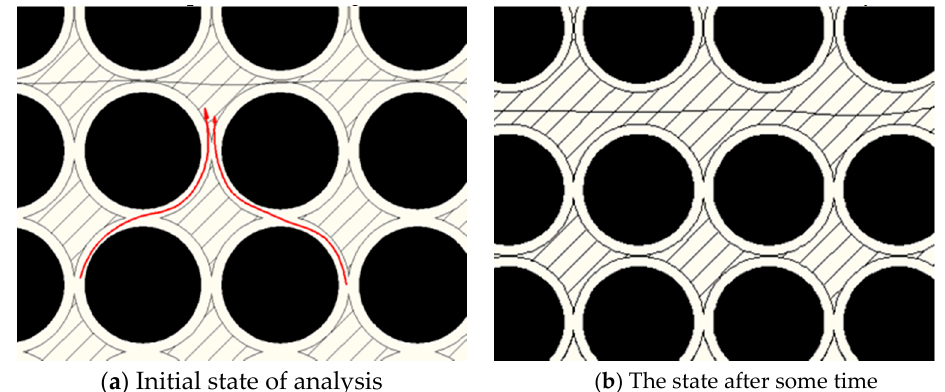
Figure 4. Schematic of freezing soil whose void ratio is less than e sep or equals to e sep : soil grains, the circles filled with black shadow; ice crystals, the circles or ellipses with slashed shadow; the ice block, the slashed shadow area; the thin unfrozen water film, the annulus outside the filled circle; the curve represents the potential position x sep of the ice lens; and the other symbols represent the unfrozen water.